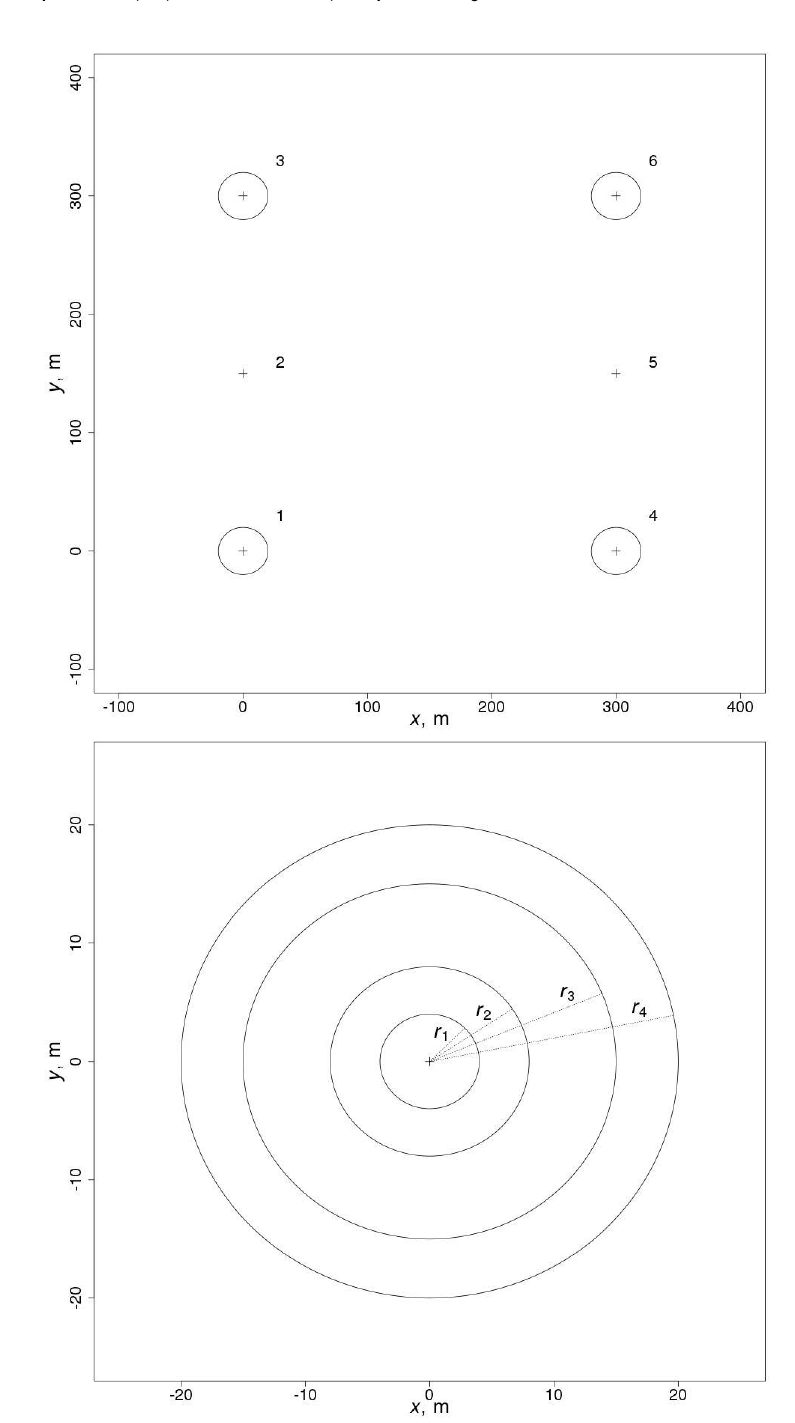
Figure 2. Layout of the inventory cluster ( a ) and Concentric Circular Sample Plot (CCSP) ( b ) used in the FRA Nepal project. In the case of Terai, one cluster comprises four CCSPs (1, 3, 4 and 6) in a square with 300 m sides, i.e. , plots number 2 and 5 of the basic cluster, which are used in the visual interpretation (first stage sample) and are excluded from the field inventory (second stage sample). In (b), the symbols r four circular plots (4, 8, 15 and 20 m, respectively) within the